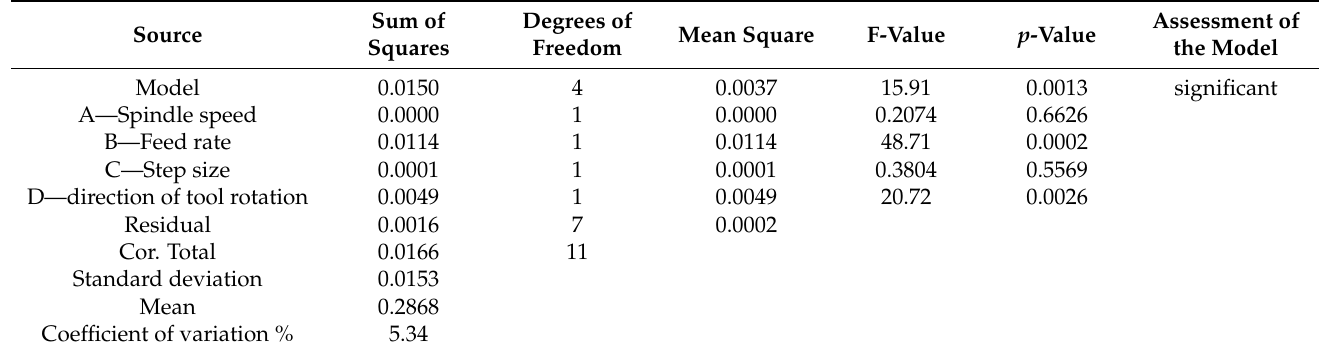
Table A2. ANOVA results of the Sdq parameter measured on the inner side of the drawpiece.